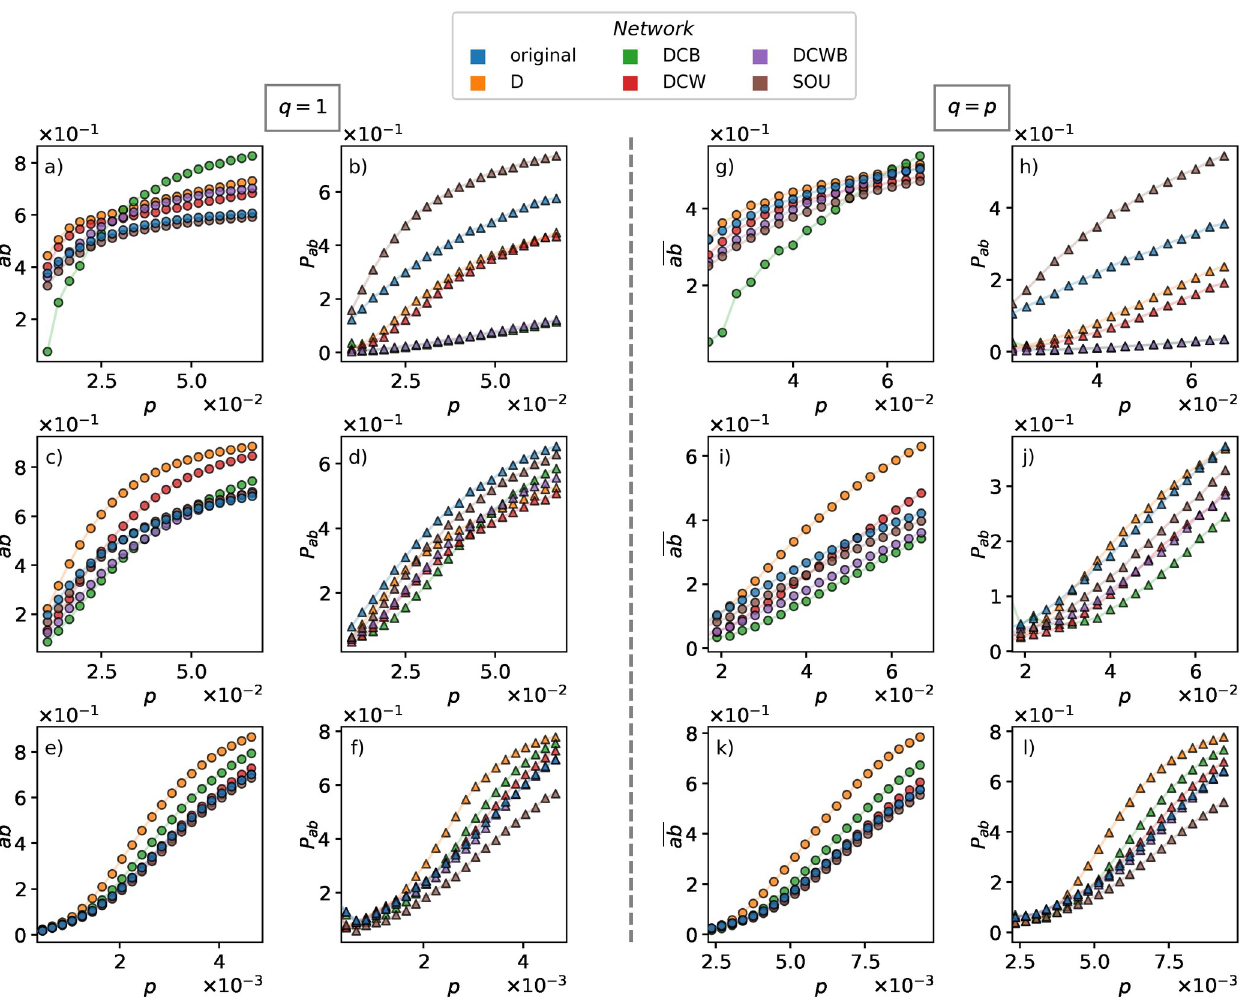
Fig 5. Mean of the outbreak size ( ab ), columns 1 and 3, and the outbreak probability ( P ab ), columns 2 and 4, for coinfective SIR-SIR ( q = 1), columns 1 and 2, and independent SIR-SIR dynamics ( q = p ), columns 3 and 4. First, second and third rows shows results for hospital, conference and primary school networks respectively. These values are respectively obtained based on the introduced method in the Fig 4 right panel, i.e., the fraction and average ρ triangles in the right